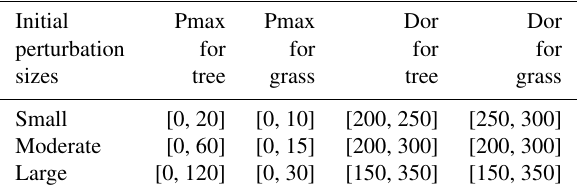
Table 2. Initial perturbation